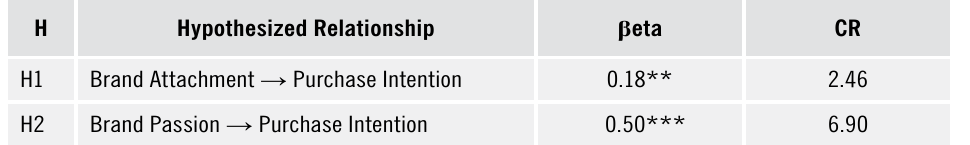
Table 5. Hypotheses